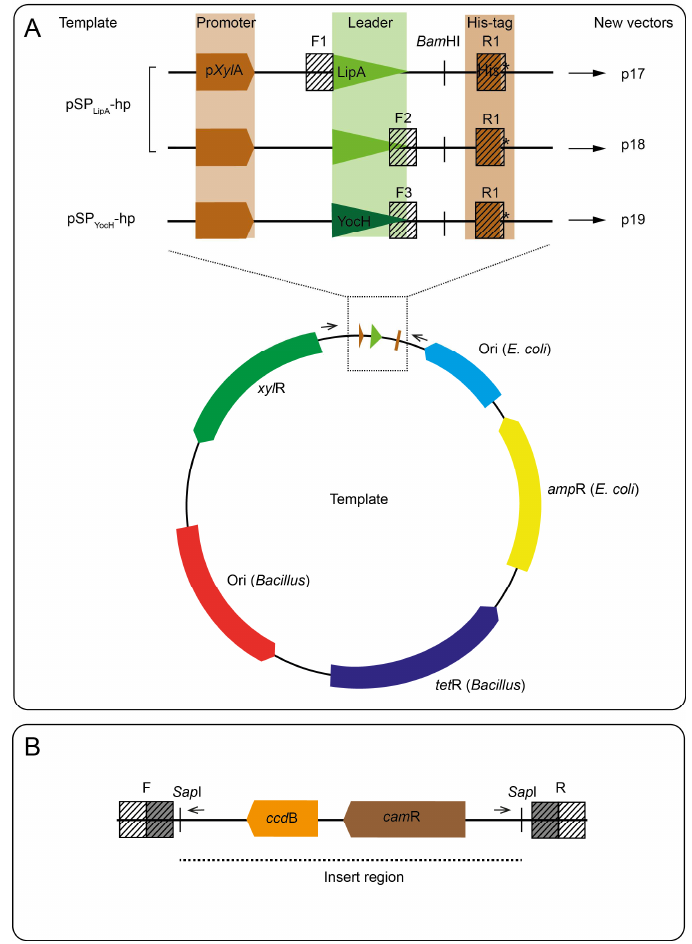
Figure 1. Design of fragment exchange (FX) compatible Bacillus expression vectors. ( A ) The vector templates, pSP LipA -hp and pSP YocH -hp, have a common backbone consisting of two origins of replication (one for E. coli and one for Bacillus ), two antibiotic resistance genes (for ampicillin selection in E. coli and tetracycline selection in Bacillus ) and the Bacillus gene encoding the regulatory protein, XylR . The highlighted regions (upper panel) consist of the Bacillus p Xyl A promoter, two different leader sequences (LipA and YocH leader sequences, respectively), and C-terminal histidine affinity tags (His-tag) for downstream purification of the recombinant proteins. The hatched boxes (F- and R-sites) indicate the vector-specific regions used for insertion of the ccd B- cam R cassette. Bam HI indicates the restriction site used for linearization, and arrows indicate position and direction of screening primers; ( B ) The region inserted between the F-sites and the R-site of the pSP LipA -hp and pSP YocH -hp templates to generate the three vectors p17, p18 and p19, as shown in A , by whole plasmid amplification. The region contains the ccd B and cam R genes, and flanking Sap I sites. Hatched boxes marked F and R are specific to each vector design and consists of two parts; it has an overlapping region for gene-specific amplification (filled boxes), and extensions that are complementary to the insertion site (open boxes) in the templates (F = either F1, F2 or F3; R = R1, as indicated in A ). The insert region designates the region in the final vectors that is replaced upon sub-cloning of recombinant genes, and arrows show position and direction of sequencing primers.